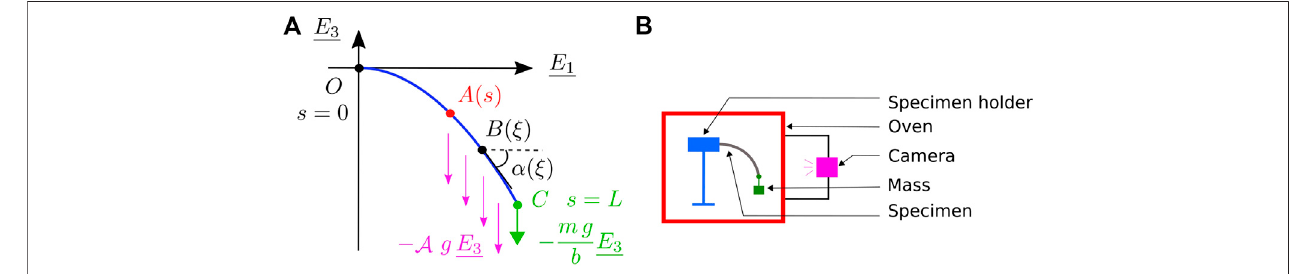
FIGURE 7 | (A) Principle and notations for the bending moment calculation with Eq. 7 and (B) schematic of the bending